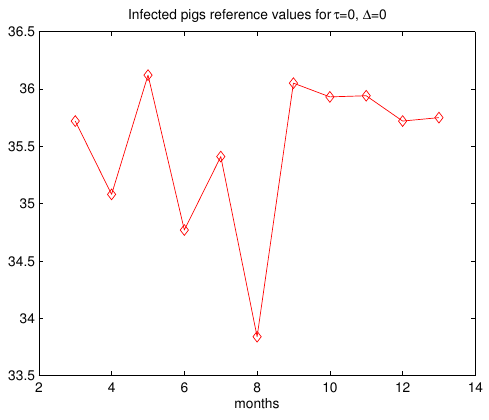
Fig. 10 Reference values in the fattening unit for no external contamination rate and biohazards, τ = 0, ∆ = 0, with an average value of 35 . 48%.